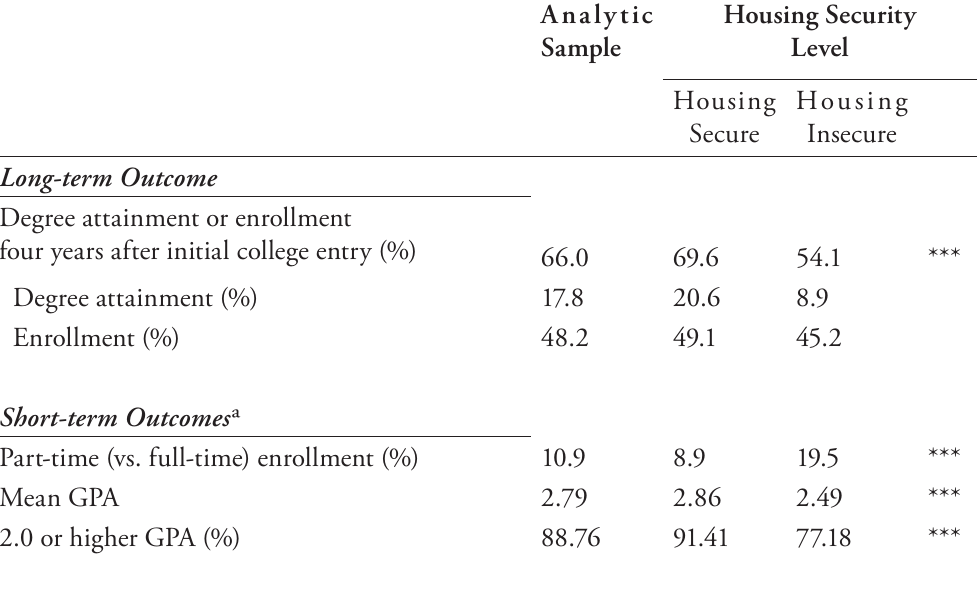
Table 1: Student background characteristics and outcomes by housing security